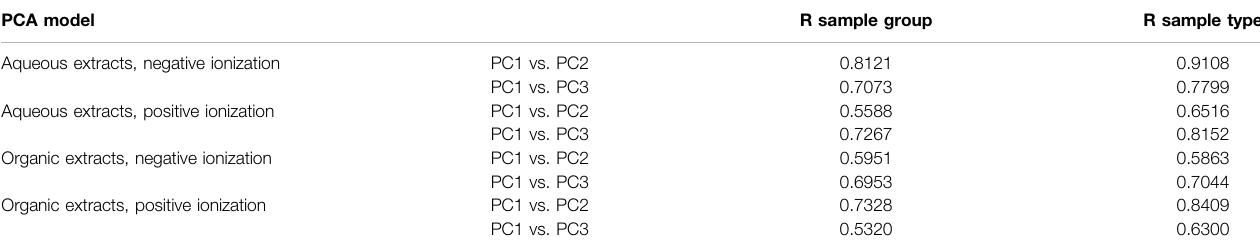
TABLE 2| SummaryoftheresultsfromANOSIM testingtoevaluatestheclusteringinPCA scoresplots.Thesigni fi cancelevelsfortheANOSIM wassetto p (cid:2) 0.001andthe analysis was performed comparing the clustering of sample groups as well as sample types, i.e., frozen samples, fi rst extracts etc. PCA model